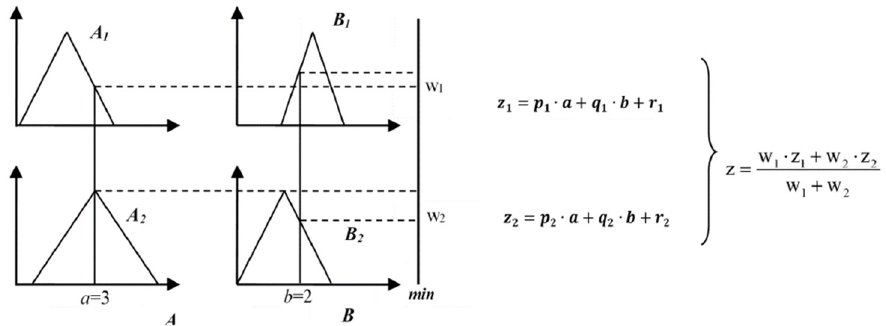
Figure 2. Example of a Sugeno model (estimation of two fuzzy rules with two input variables, b = 2 and a = 3 ).